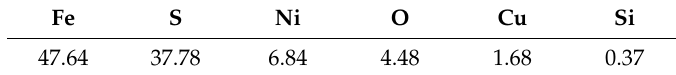
Table 1. Key element composition of sulfide ore sample (wt %).